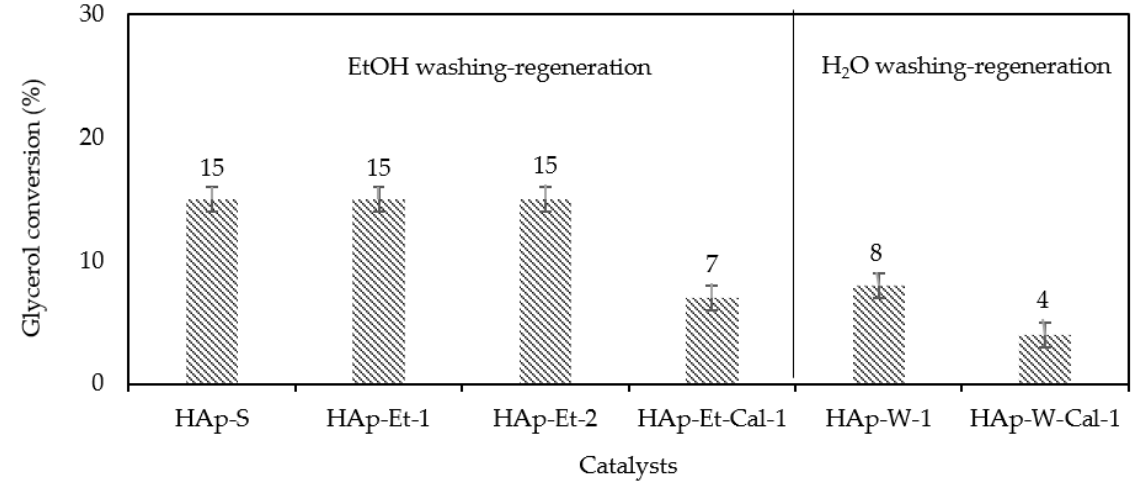
Figure 3. The catalytic activity of fresh HAp-S and recovered catalysts with washing using EtOH or H 2 O.